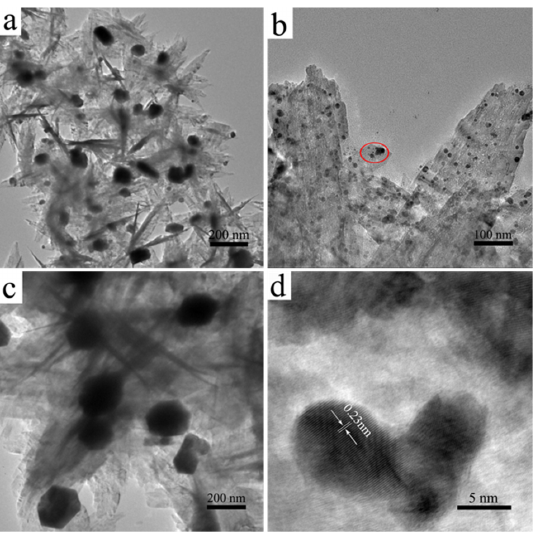
Figure 5. The TEM images of CuO@Ag nanosheet composites: ( a ) aged time: 0 min, without PAA; ( b ) aged time: 1 h, 10% PAA; ( c ) aged time: 1 h, 100% PAA; ( d ) the crystal lattice of the sample in black circle of ( b ).